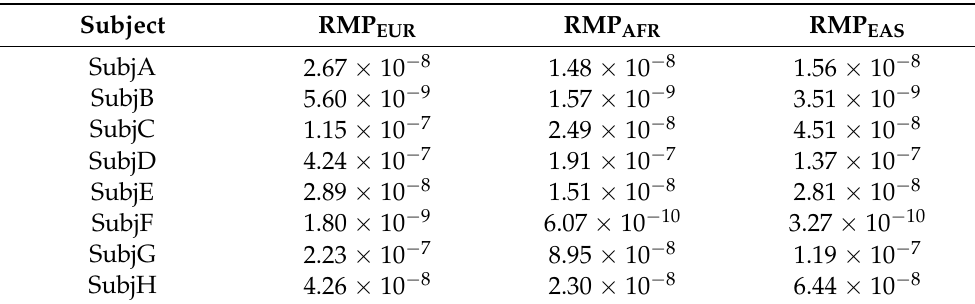
Table 4. The random match probability (RMP) values relating to the eight subjects. European (EUR), African (AFR), and East Asian